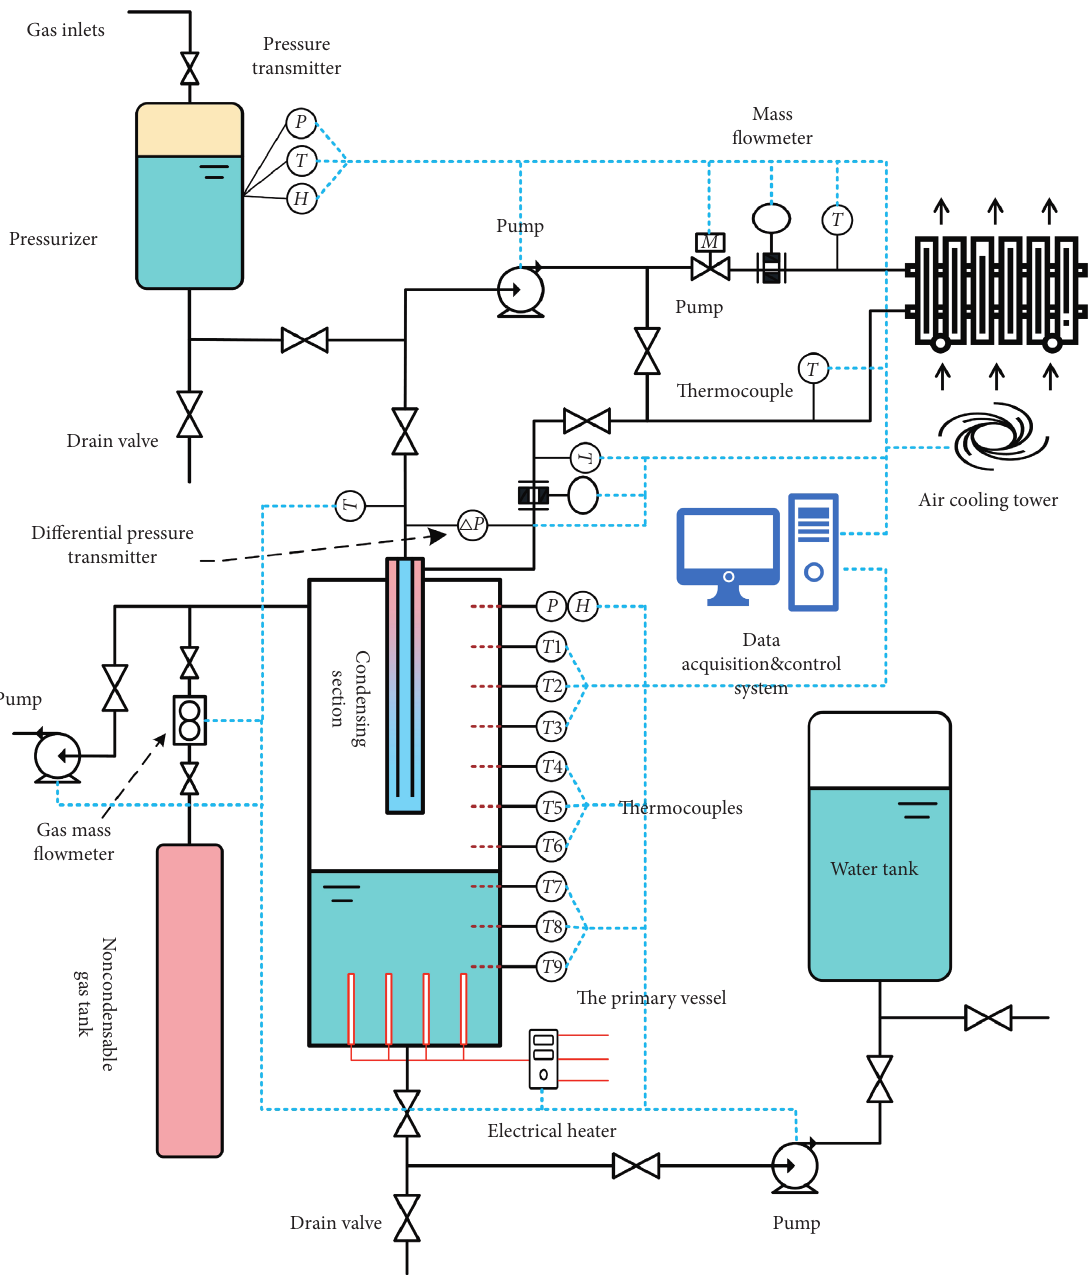
Figure 1: The steam condensation experimental system under natural